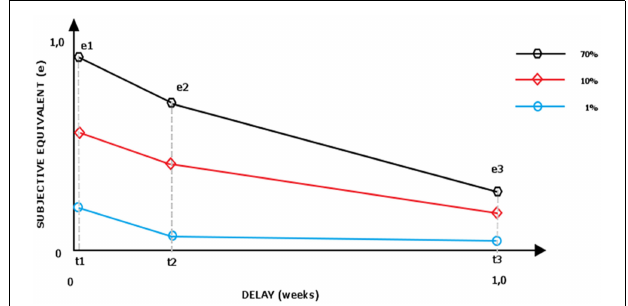
FIGURE 1 | Area under the curve for hypothetical three delayed lotteries